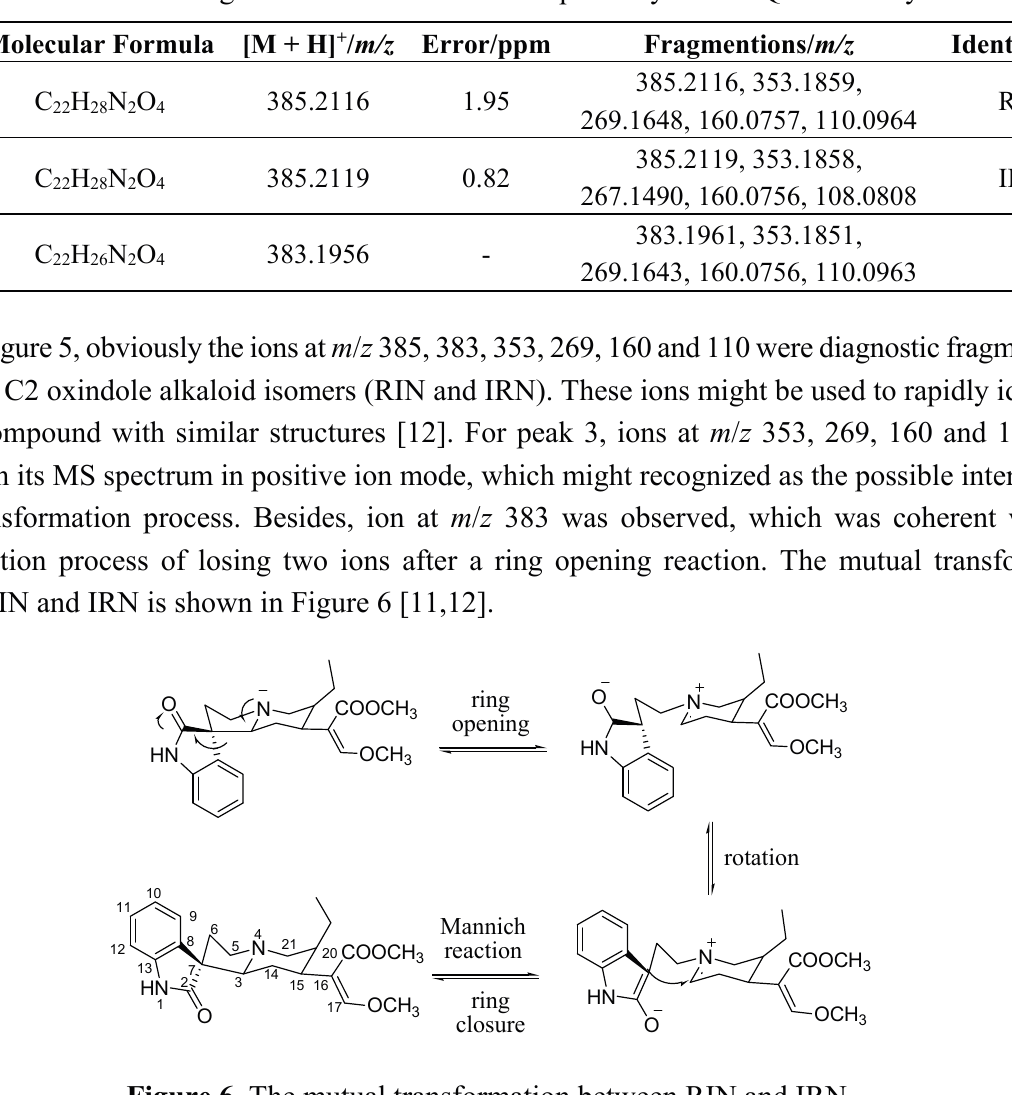
Figure 6. The mutual transformation between RIN and